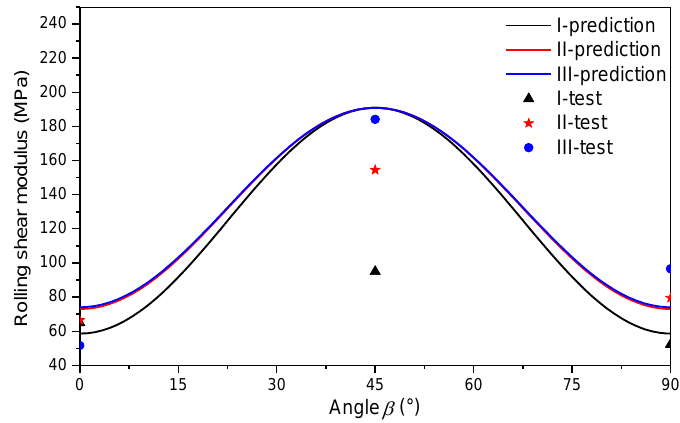
Figure 7. The apparent rolling shear modulus in different grain angles. The rolling shear moduli of different groups from the test are also marked in Figure